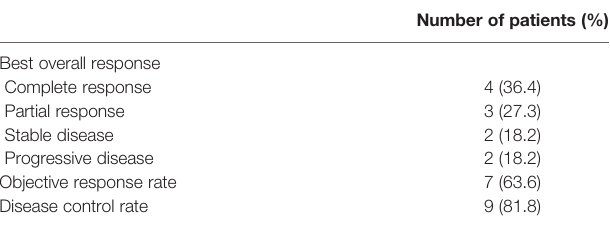
TABLE 4 | Therapeutic response after HAIC and VAX-NK/HCC therapy ( n = 11).